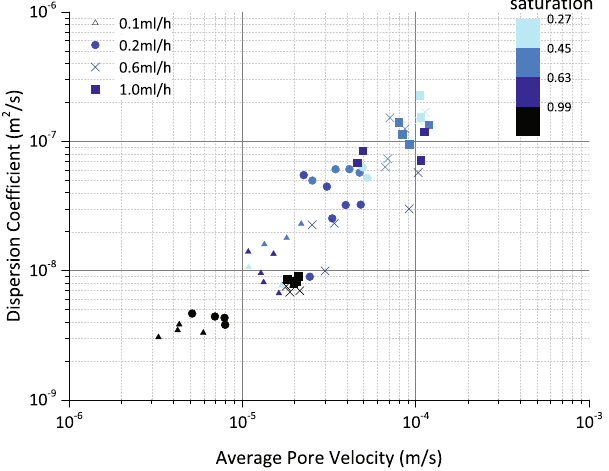
Figure 2. Dispersion coefficient plotted against average pore velocity, for the four different injection rates. The data points are attained by fitting Equation (1) to the average resident concentration versus time data. Colors coding shows the saturation class of each data point. Black color shows the fully-saturated cases and cyan color shows the saturation of 0.27. The other two blue colors show the intermittent ranges of saturation.